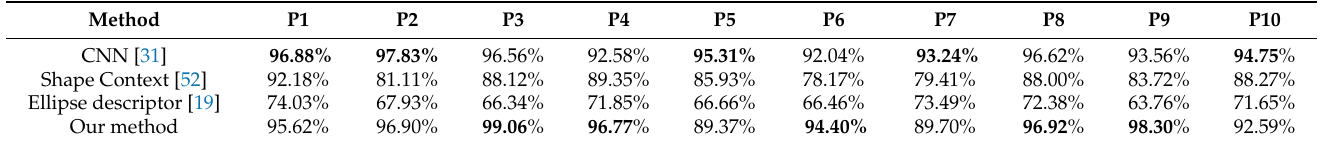
Table 8. Postures classification comparison using Dataset D1.